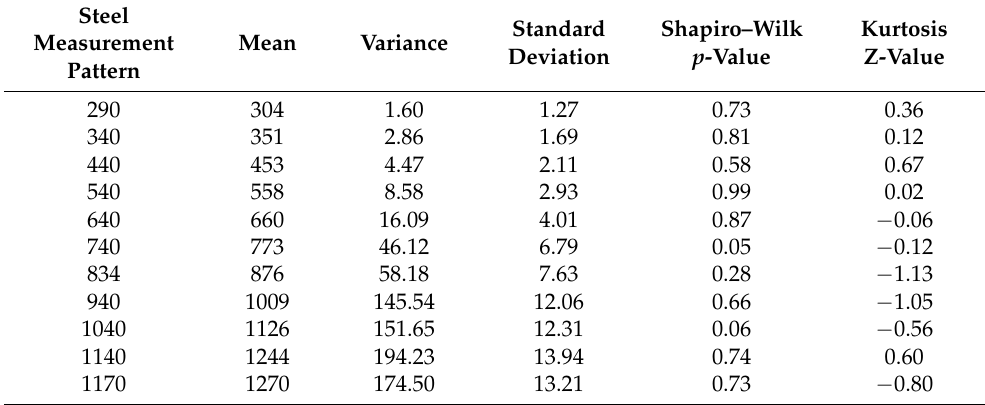
Table 6. Statistical analysis of VL53L1X for tests with ambient light.